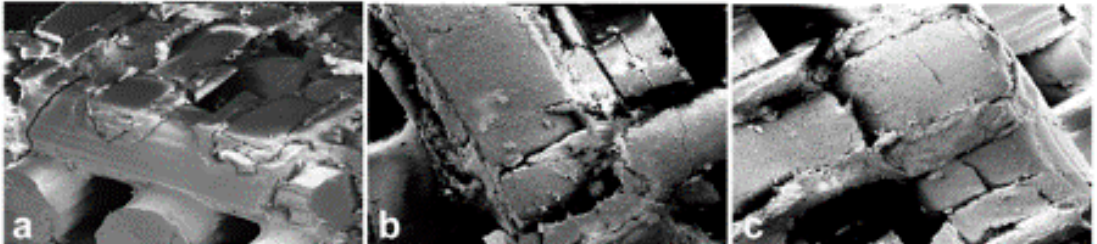
Figure 5. ( a – c ) Scanning electron microscopy images, with different details, of the 3D printed bone substitute biomaterials (BSBs) (small pores) after compression loading. The structure made of concentric cylindrical shells is present also in this case, with fractures originating from the exfoliation of these shells, especially in the nodes of the structure ( b , c ). Original magnification: ( a ) 46×; ( b ) 89×; ( c ) 90×.